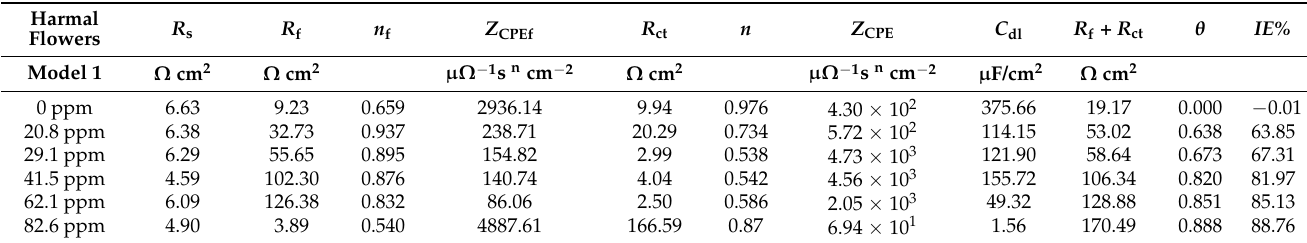
Table 5. Impedance parameters for the Harmal flower extract on the C-steel in 0.25 M H 2 SO 4 medium by fitting the equivalent circuit model 1.